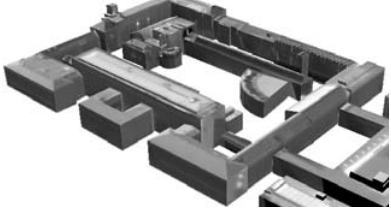
Figure 3. Test area “TUM”: Textured 3D building model.